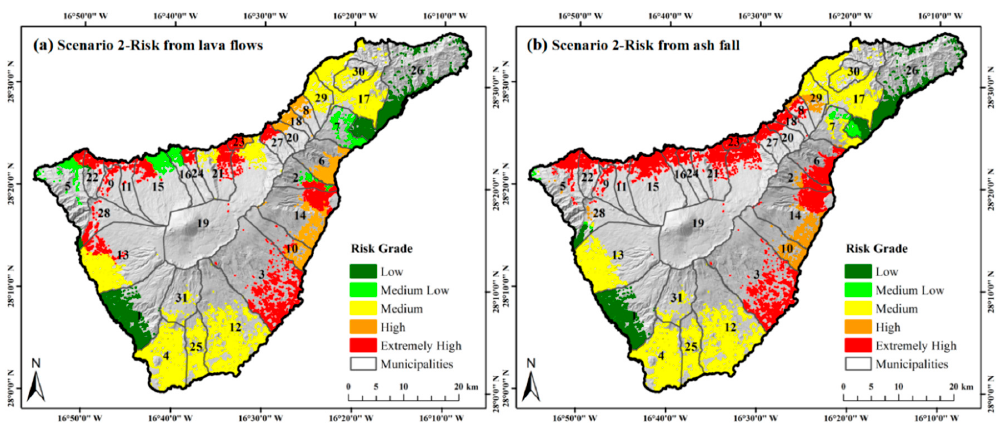
Figure 14. Volcanic risk grading map of Tenerife in Scenario 2. ( a ) Risk from lava flows. ( b ) Risk from ash fall.